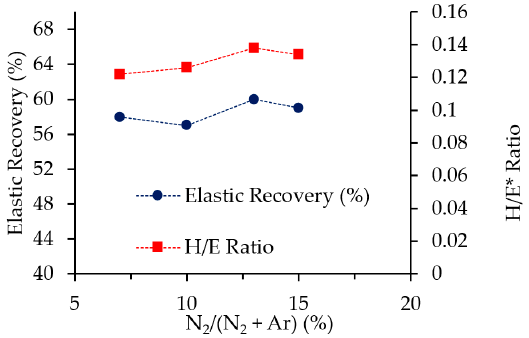
Figure 9. Variation in H / E * ratio and elastic recovery W e (%) of the films as a function of N 2 content.